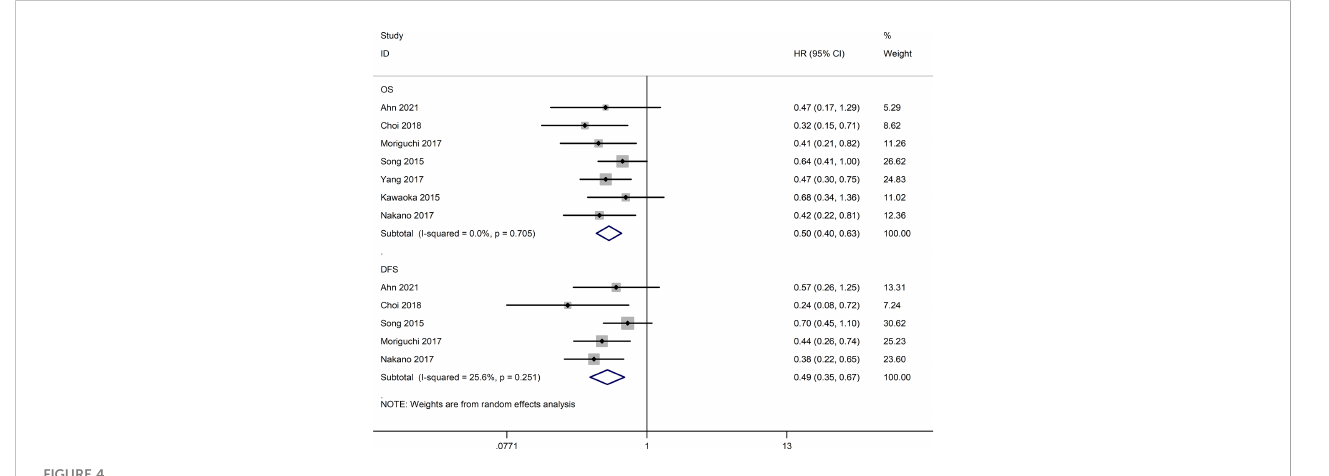
FIGURE 4 Forest map of overall survival and disease-free